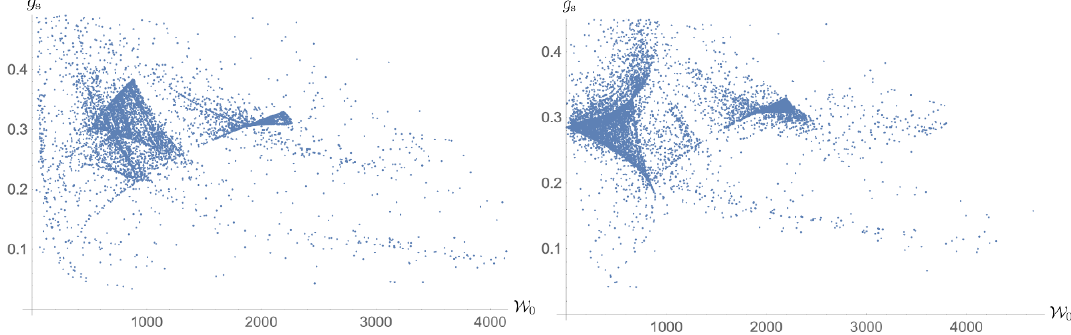
Figure 12 . The distribution of vacua in the W 0 - g s -plane for generation 10 (left) and 30